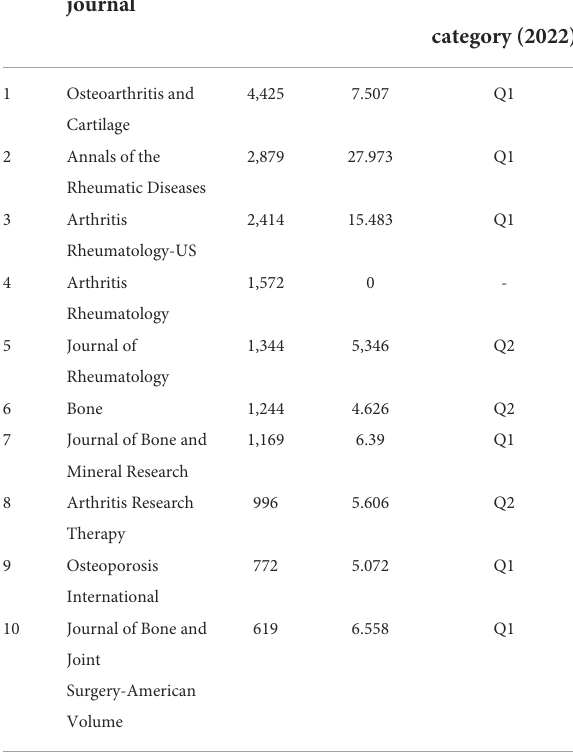
TABLE 5 Top 10 co-cited